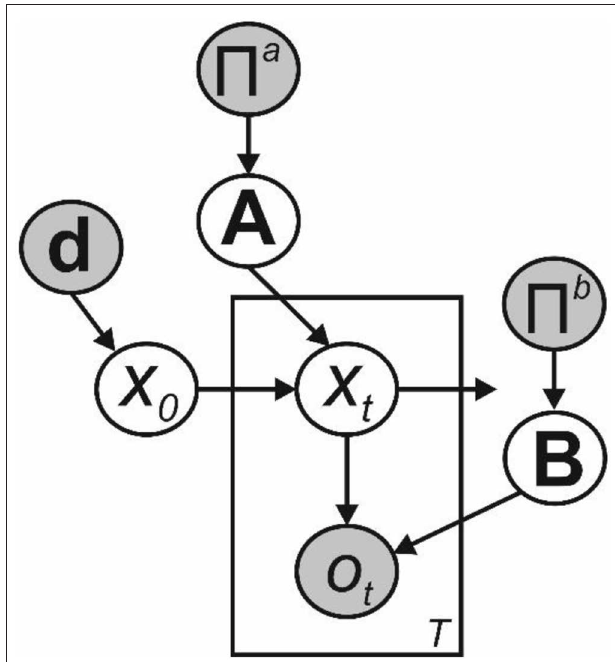
FIGURE 2 | Bayesian graph illustrating the structure of the Hidden Markov model described in the text (Shaded circles indicate variables with known values, unshaded circles indicate hidden variables). Transitions between hidden states x 0 to x T are governed by the transition matrix A , and are first-order Markovian. Observations o 1 to o T depend only on the current hidden state and the emission matrix B . Where the parameters of A and B need to be learnt, as depicted here we include appropriate sets of Dirichlet priors, parameterized by the matrices 5 a and 5 b , respectively. Beliefs about the initial hidden state x 0 are governed by the parameter vector d